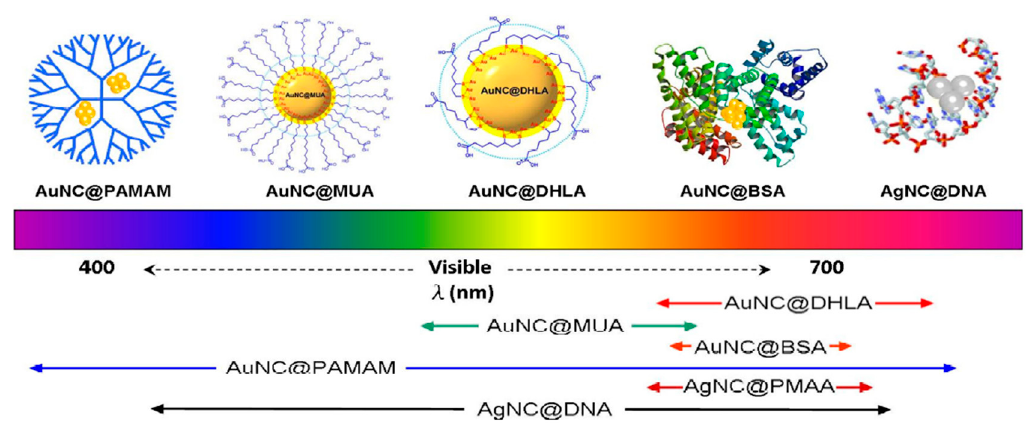
Figure 5. Representative luminescent noble–metal nanoclusters scaled as a function of their emission wavelength superimposed over the spectrum. Protected molecules show different capabilities to tune the emission wavelength of metallic nanoclusters from current reports.